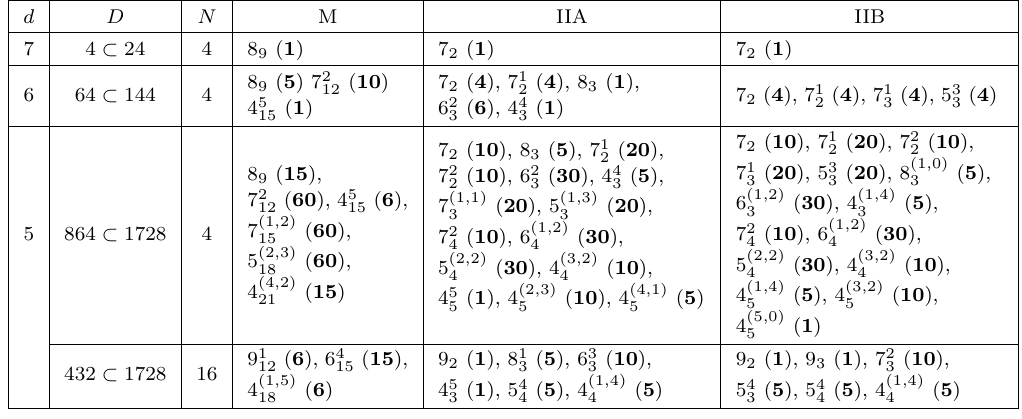
Table 19 . Missing states in the 4-brane multiplet.